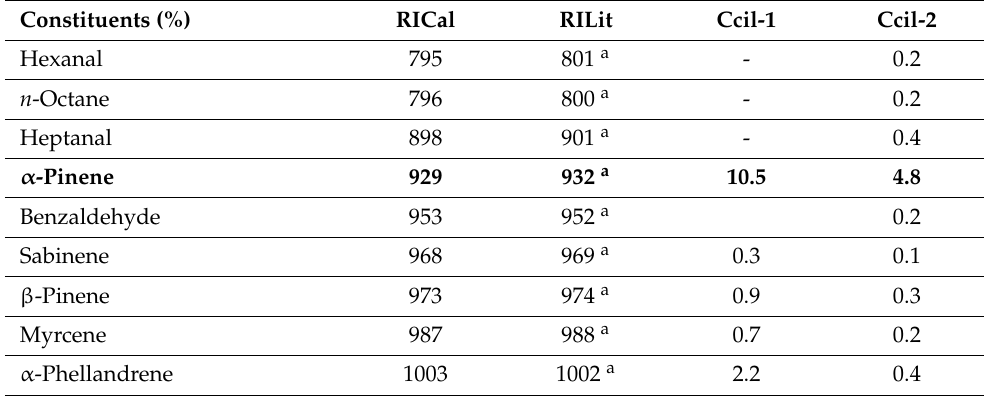
Table 4. Constituents identified in the volatile concentrates of two specimens of C. ciliatum flow- ers.